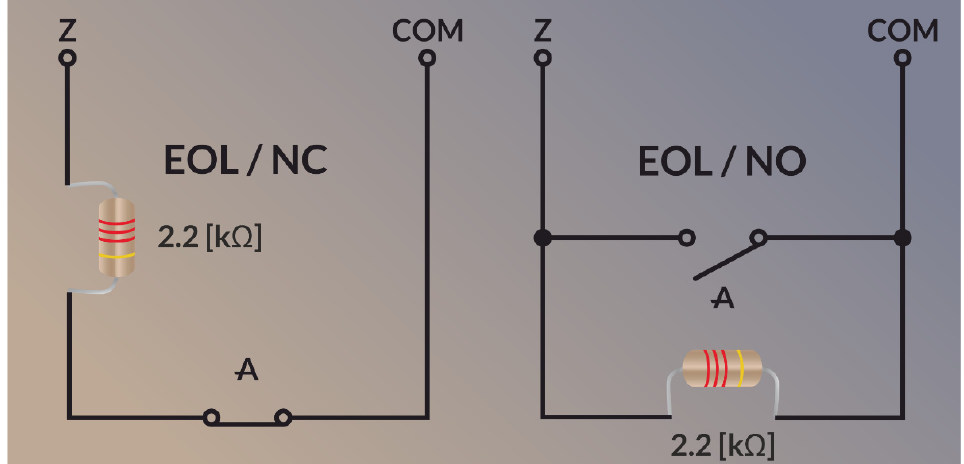
Figure 2. Structure of a parametric detection circuit of and EOL-type NC and NO IDS. The experimental system used was an Integra 64 control panel, hardware version 1.4